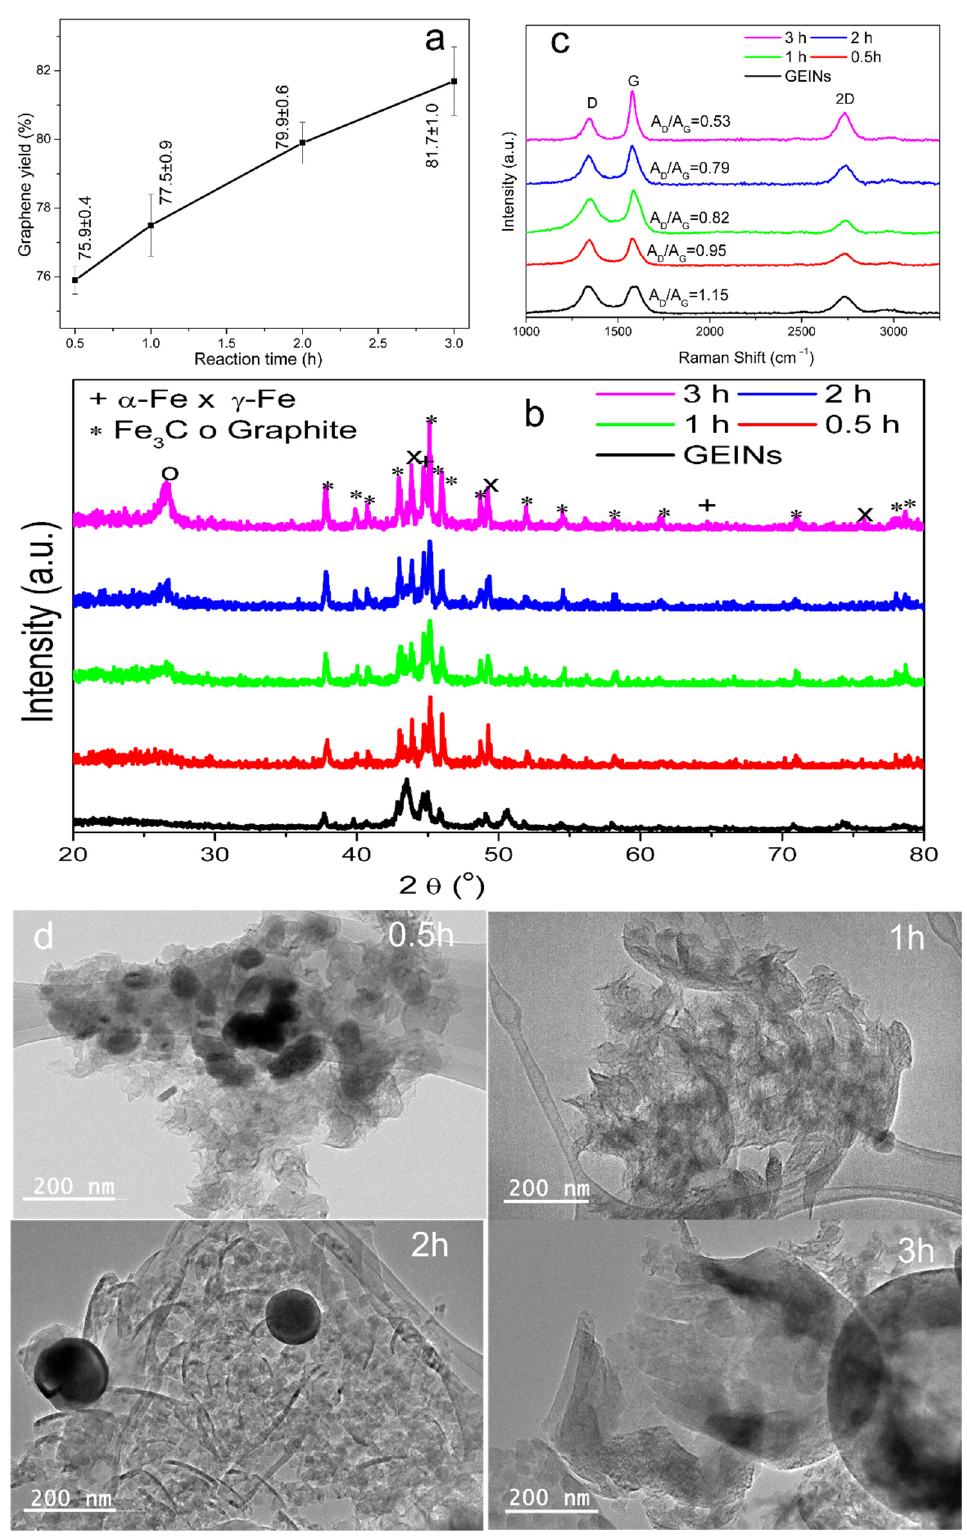
Figure 8. Yield of graphene materials ( a ), XRD patterns ( b ), Raman spectra ( c ), and HRTEM ( d ) images of the cracked GEIN samples using methane at 1000 °C with different reaction times.